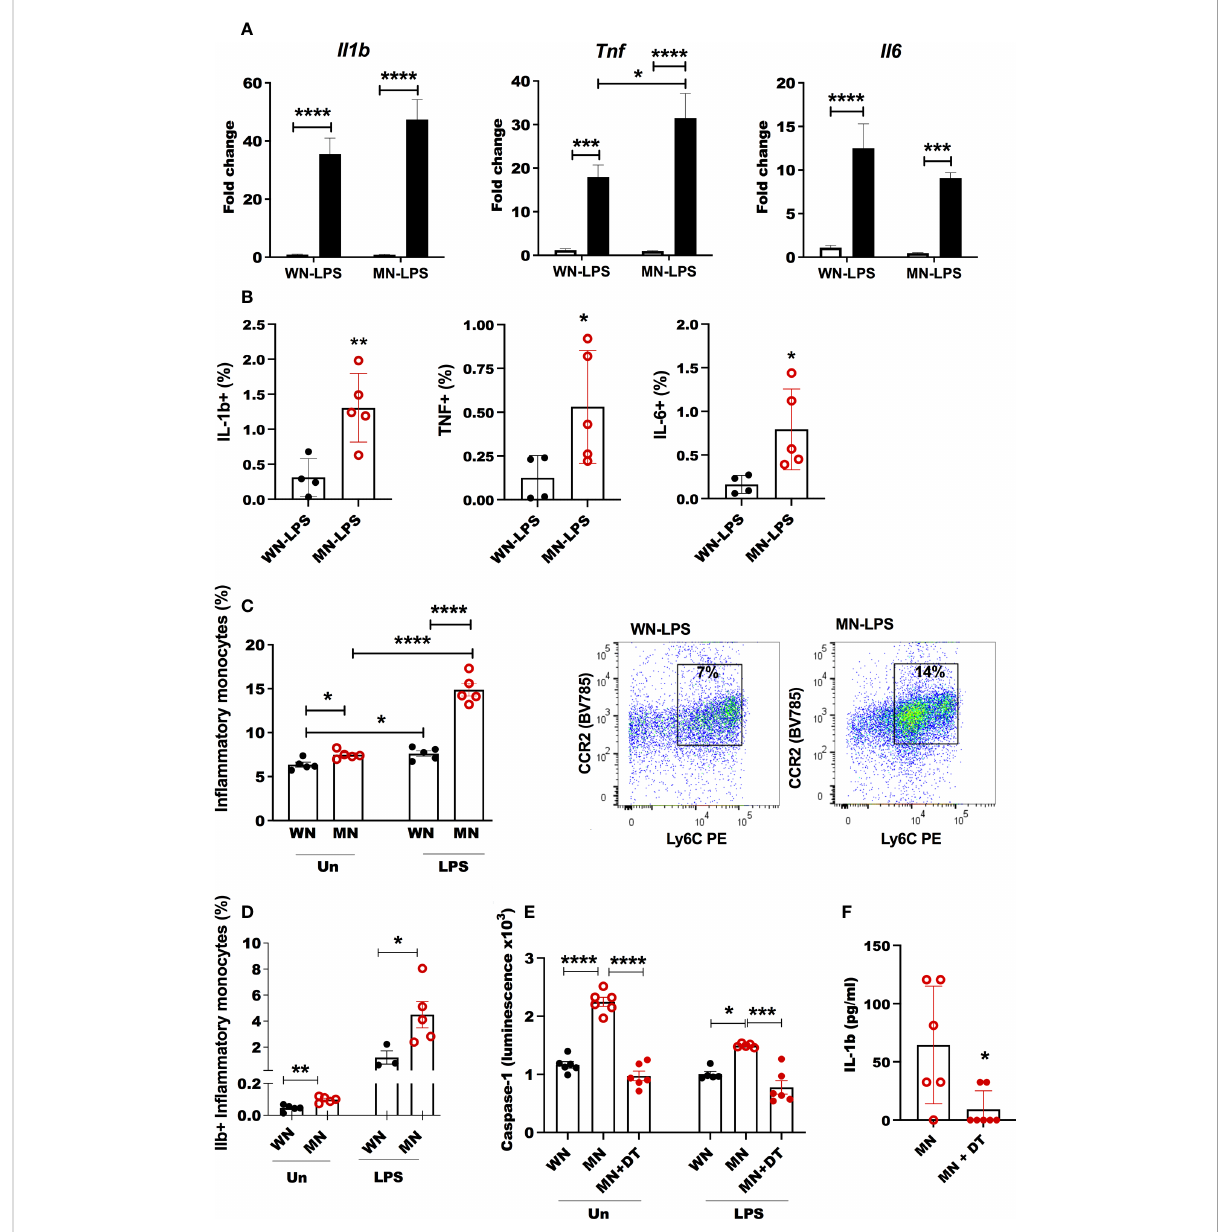
FIGURE 7 Heightened in fl ammatory response in bone marrow of malnourished mice following in fl ammatory challenge. (A) Expression of in fl ammatory cytokines interleukin-1 b ( Il-1b ), tumor necrosis factor ( Tnf ) and interleukin-6 ( Il6 ) in bone marrow of well-nourished (WN) or malnourished (MN) mice that were naïve unchallenged (Un) or challenged with LPS. Bone marrow was obtained 24h after LPS challenge and expression (fold change) relative to unchallenged WN mice, determined by qRT-PCR. (B) Percentage of IL-1ß, TNF and IL-6 in in fl ammatory monocytes in LPS challenged mice by fl ow cytometry. (C) Percentage of in fl ammatory monocytes (CD11b+Ly6C int/hi Ly6G-CD11c-) relative to total bone marrow cells in well-nourished (WN) or malnourished (MN) mice that were naïve unchallenged (Un) or challenged with LPS or L. donovani (L.d.) determined by fl ow cytometry. Right: representative dot-plot showing in fl ammatory monocytes (CCR2+Ly6Chi/int) in LPS challenged mice, (gated as Supplementary Figure 1E). (D) Proportion of in fl ammatory monocytes containing Il-1ß naïve unchallenged (Un) or challenged mice with LPS by fl ow cytometry. (E) In fl ammasome activation in bone marrow cells from Csfr1-LysMcre-DT malnourished (MN) mice treated or not with diphtheria toxin (+DT) to deplete in fl ammatory monocytes, compared with Csfr1-LysMcre-DT well-nourished mice (WN) after 1h of in vitro exposure to LPS or left unchallenged (Un); determined by luminometry with Caspase Glo-1 in fl ammasome assay. (F) Active Il-1ß in the bone marrow of Csfr1-LysMcre-DT malnourished (MN) mice challenged with LPS treated or not with diphtheria toxin (+DT) to deplete in fl ammatory monocytes. Determined by luminex. N=5 mice per group, 2 experiments. *p<0.05, **p<0.01, ***p<0.001,